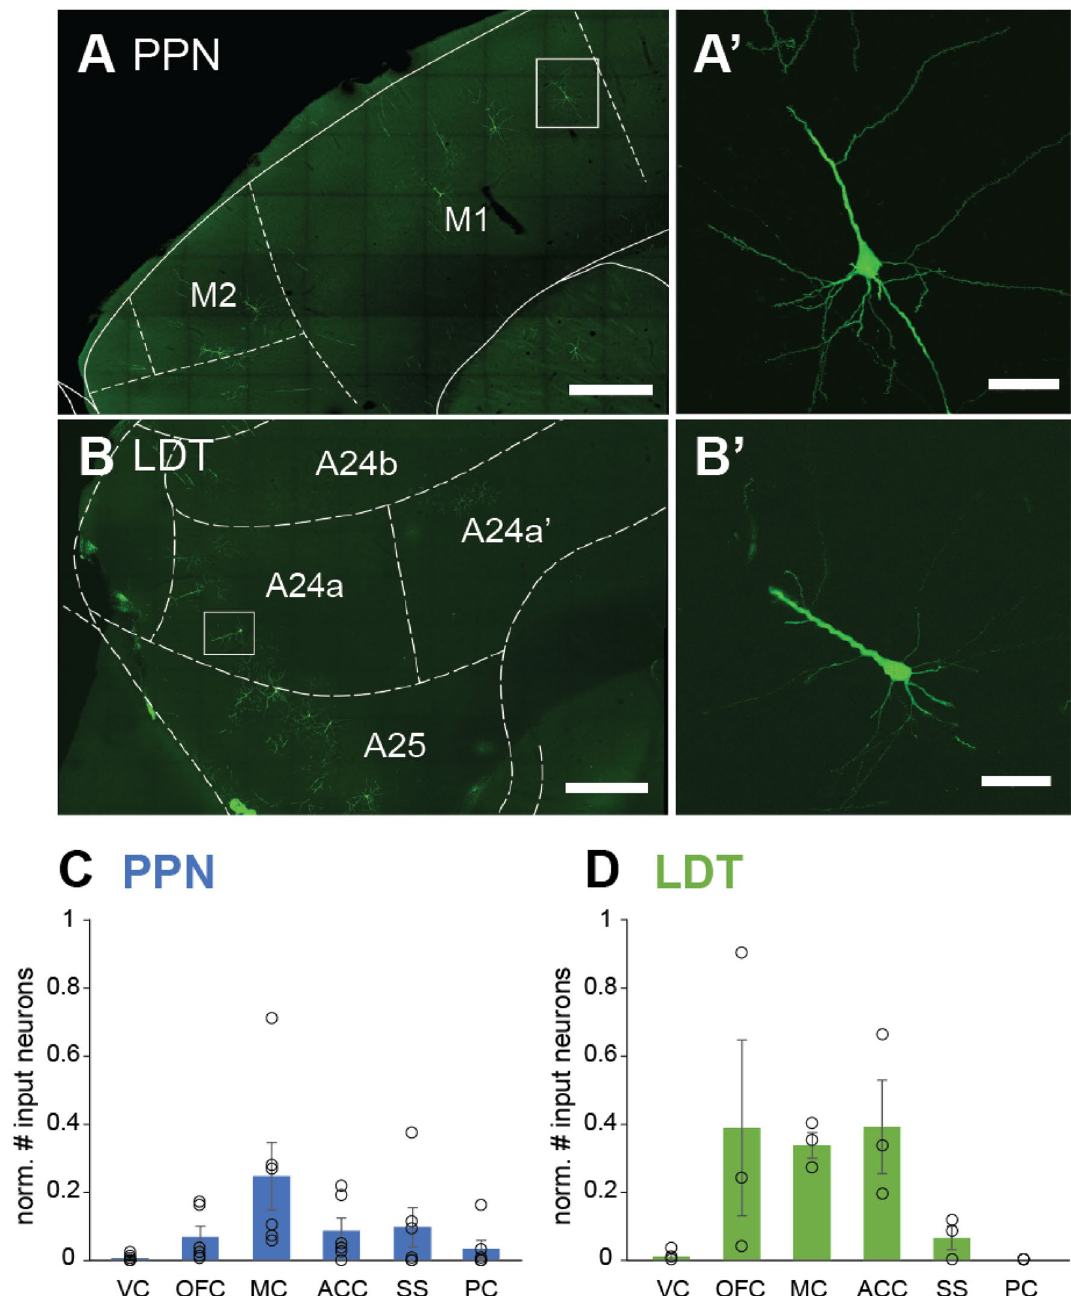
Figure 4. Distinct distribution of input neurons across cortical regions. ( A ) Fluorescent micrograph showing cortical input neurons to PPN cholinergic cells located in the motor cortex in a parasagittal section. ( A ′ ) High magnification image of neuron in M1 (box in A ). ( B ) Fluorescent micrograph showing input neurons to the LDT in the anterior cingulate cortex in a sagittal section. ( B ′ ) High magnification image showing a neuron located in A24a (box in B ). ( C ) Number of input neurons across cortical areas that innervate the cholinergic neurons of the PPN ( C ) and the LDT ( D ), normalized to the number of starter neurons. VC, visual cortex; OFC, orbitofrontal cortex; MC, motor cortex (M1/M2); ACC, anterior cingulate cortex; SS, somatosensory cortex; PC, parietal cortex. Mean ± SEM (PPN n = 6 rats; LDT n = 3 rats). Scale bars: ( A ) and ( B ): 500 µm, ( A ′ ) and ( B ′ ): 100